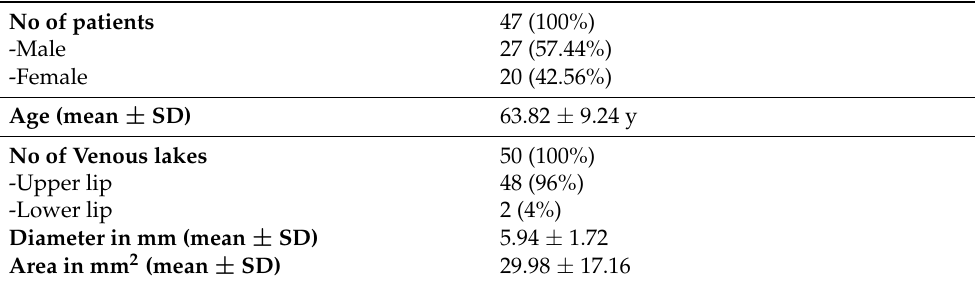
Table 2. Demographic and clinical characteristics of the patients at